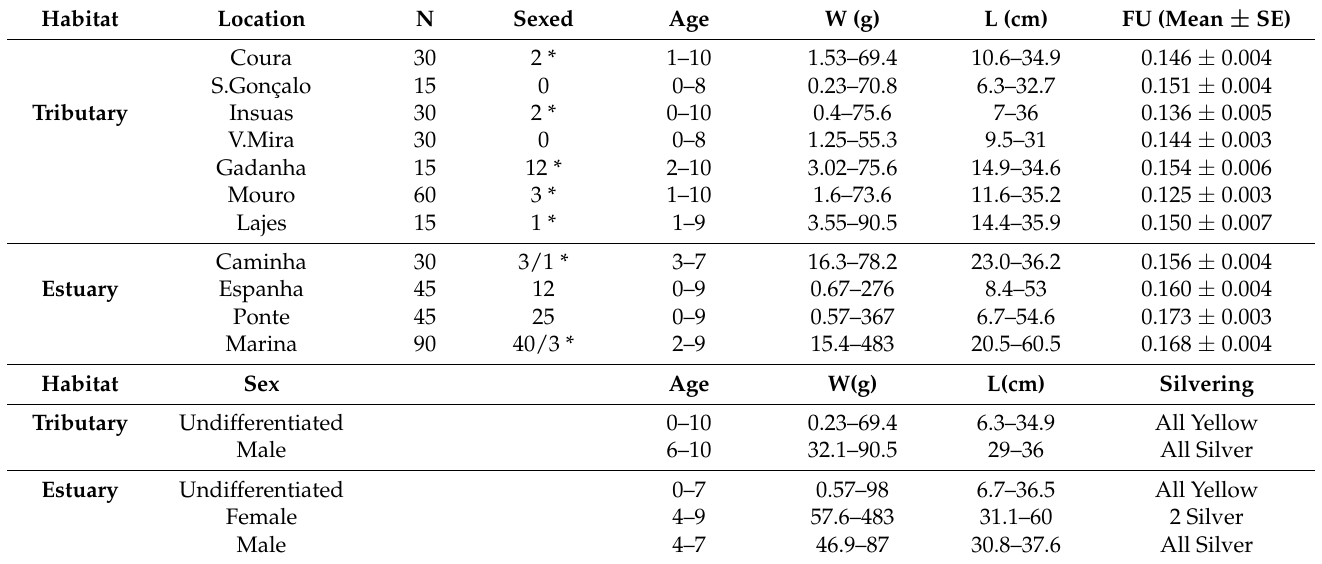
Table 2. Number of eels collected in the Minho River according to habitat and sampling location (N), number of macroscopically sexed eels (males *), minimum and maximum age, weight (W), length (L), and mean ( ± standard error, SE), Fulton’s condition factor (FU). Data also include age, W, L, and silvering stage of undifferentiated, male, and female eels according to the